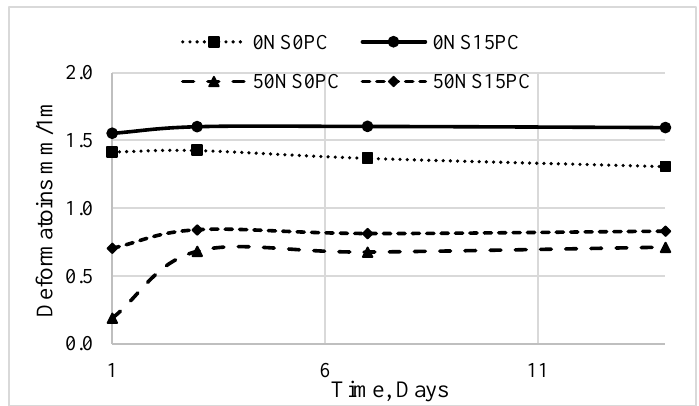
Figure 5. AAC samples expansions due to ASR.